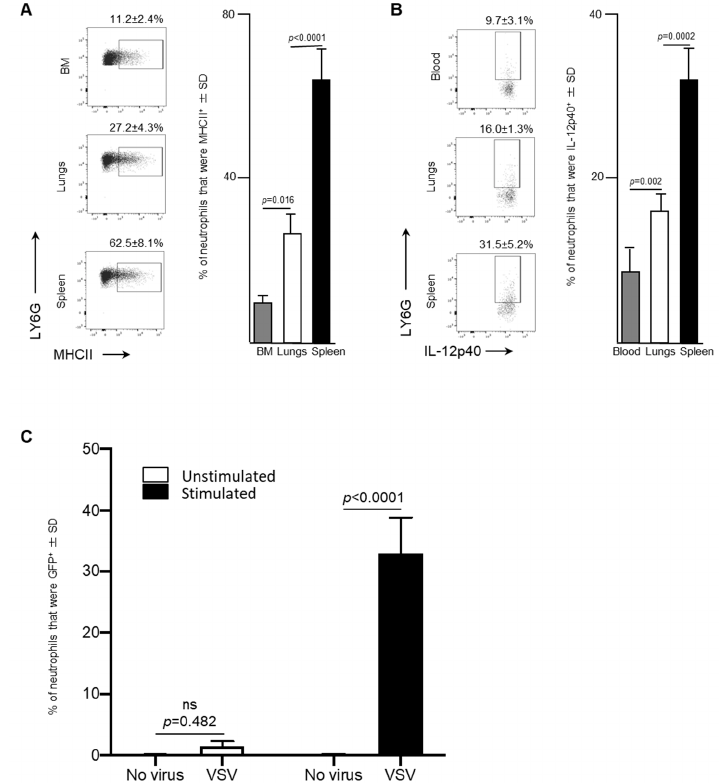
Figure 4. After exposure to vesicular stomatitis virus (VSV) splenic neutrophils expressed high concentrations of major histocompatibility complex II (MHCII), the inflammatory cytokine interleukin (IL)-12 and a viral transgene-derived protein. Six- to eight-week-old female C57BL/6 mice ( n = 8/group) were injected intravenously with 1 × 10 9 plaque-forming units of VSV or phosphate-buffed saline (PBS) and euthanized three- or 24-h (h) later. Bone marrow (BM)-, blood-, spleen- and lung-derived cells were used to quantify neutrophils by flow cytometry. Representative dot plots and graphs with means and standard deviations (SD) ( n = 8/group) are shown for the proportion of ( A ) neutrophils (defined as CD45 + Ly6G hi CD11b hi ) that expressed MHCII in the BM, lungs and spleen, and ( B ) neutrophils in the blood, lungs and spleen that expressed IL-12p40. ( C ) To test neutrophils for intracellular expression of enhanced green fluorescent protein (GFP) encoded in the genome of VSV, bulk splenocytes were harvested from six- to eight-week-old naïve female C57BL/6 mice. Splenocytes were unstimulated or stimulated in vitro with anti-CD3 and anti-CD28 for four-hours and then left unexposed to the VSV or exposed to VSV-GFP at a multiplicity of infection of 10 for 18-h. Flow cytometry was used to determine the percentage of viable neutrophils (defined as CD45 + Ly6G hi CD11b hi ) that were GFP + ; n = 10/group. (ns = not significantly different).